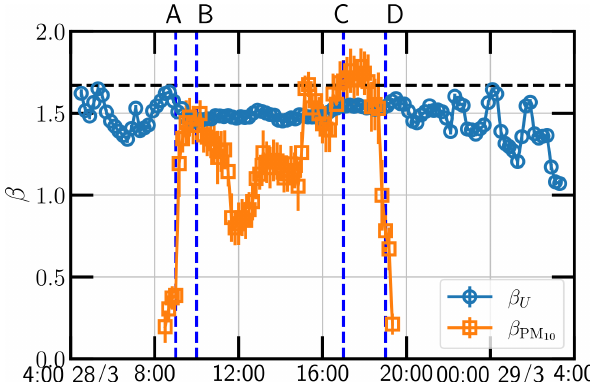
Figure 8. Temporal evolution of the scaling exponent β , which is estimated on a 1h sliding window with 80% overlap. The horizontal dashed line indicates the Kolmogorov value of 5 / 3 for reference. The vertical dash line in Fig. 4 indicates three different